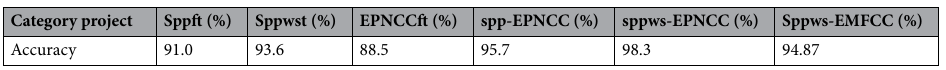
Category project